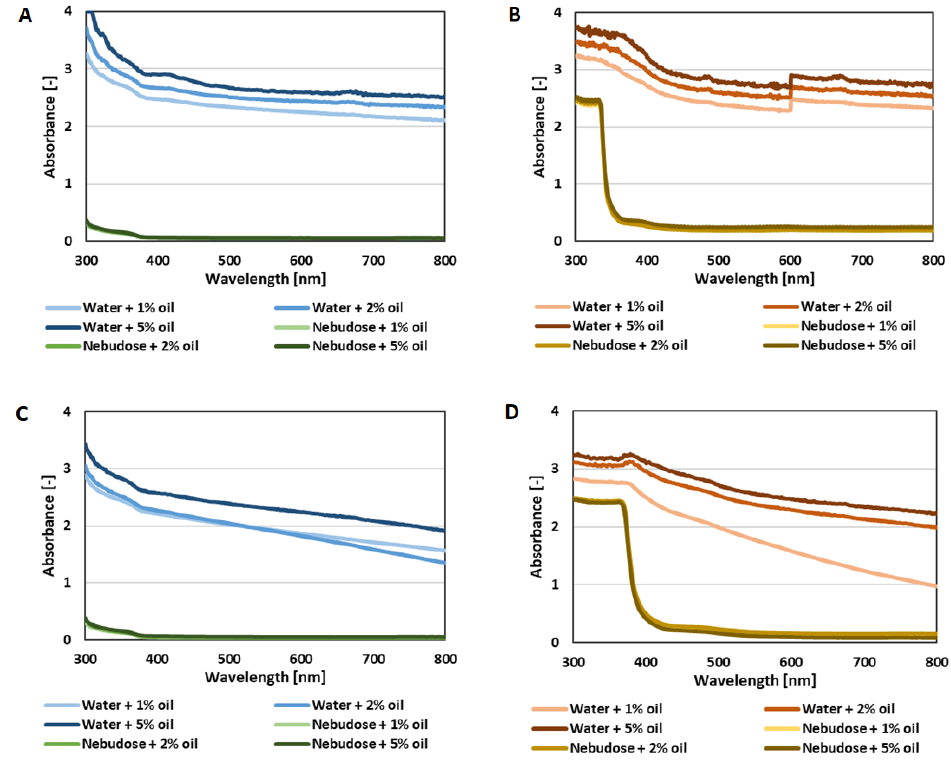
Figure 2. Visible light spectra of the emulsions after 24 h ( A , B ) and after centrifuging at 4500 rpm for 10 min ( C , D ); the samples without AHE ( A , C ) and with 2 g/L AHE ( B , D ).